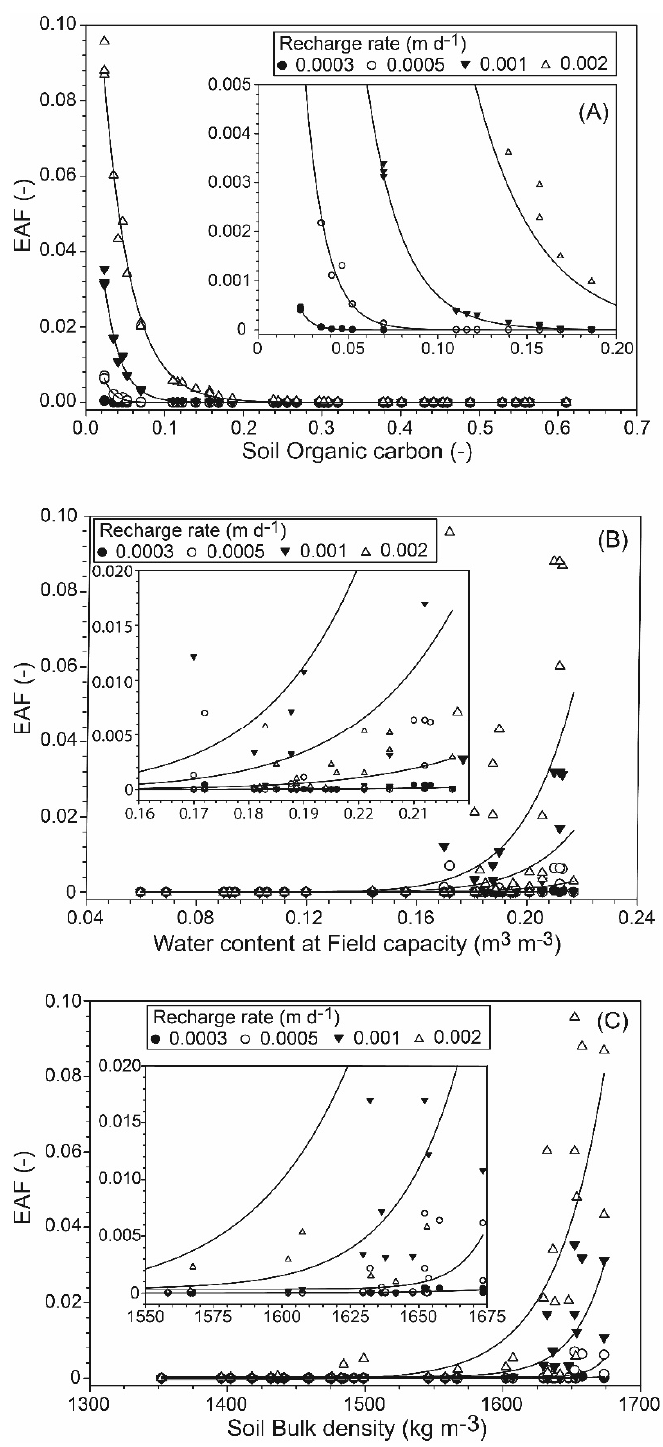
Figure 7. Effect of soil organic carbon ( A ), water content at field capacity ( B ), and soil bulk density ( C ) on average leaching potential in Jazan watershed as assessed by EAF index model under four scenarios of recharge rates.